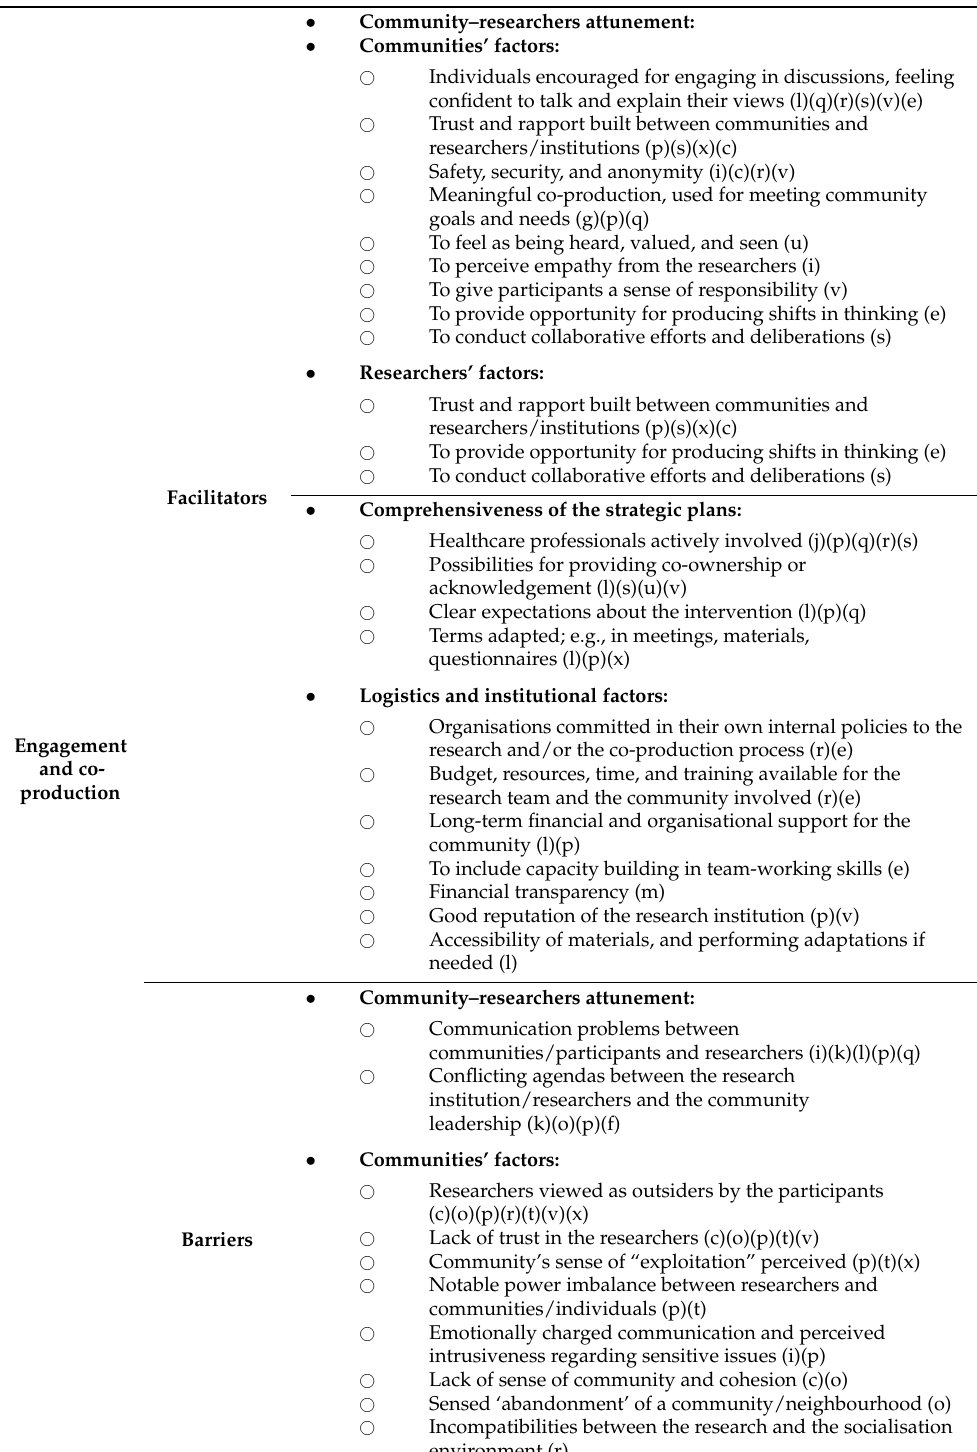
Table 5. Facilitators and barriers during the engagement of participants and the co-production